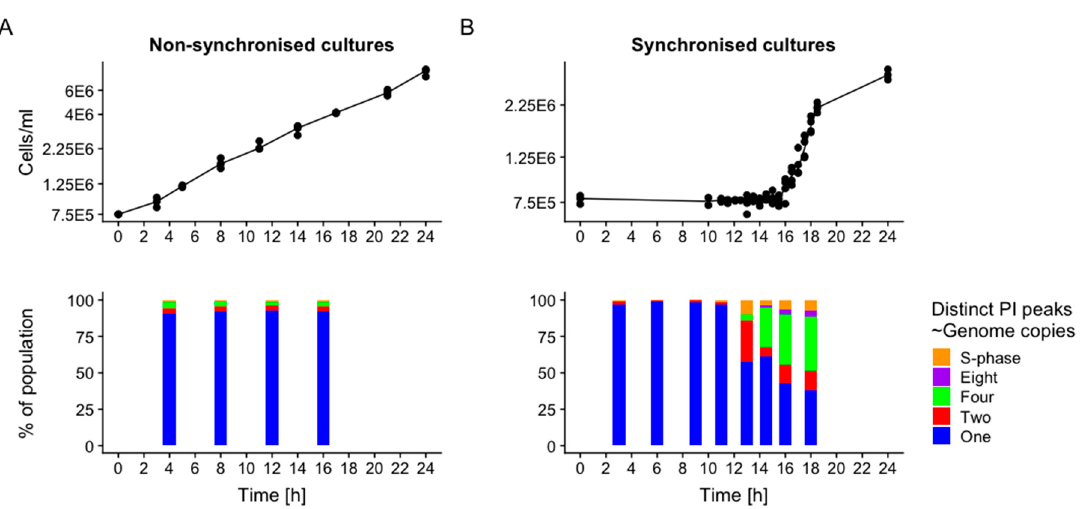
Figure 2. Cell density ( Top ) and number of distinct peaks in PI fluorescence intensity ( Bottom ; ~ amount of genomic material found in each zoosporangium or zoospore) indicating genomic division events during multiple-fission cycles for non-synchronised ( A ) or synchronised ( B ) cultures. For synchronised cultures, light:dark transition occurred at 12 h.